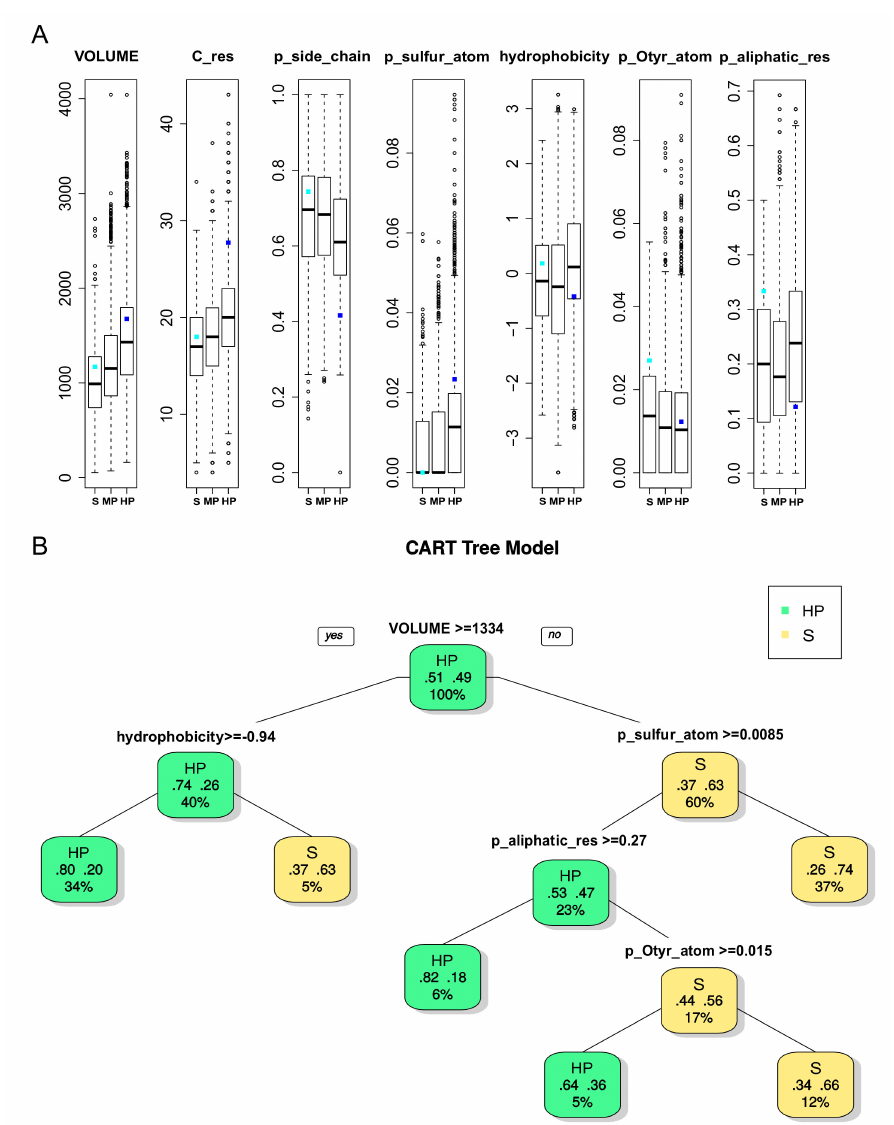
Figure 3. (A) Boxplot of seven pocket properties that di ff erentiated DBS with di ff erent levels of promiscuity (p value < 2 × 10–5). For each boxplot, the black bar in the rectangle represents the medium, the upper side is the third quartile, and the lower side is the first quartile of data. The dashed lines represent values below the first quartile limit and values above the third quartile limit. Circles represent atypical values (determined by the boxplot function). The cyan dot and the blue dot represent the values of the ligand in interaction with a lyase selective DBS (PDB 4KVI) and an urokinase HP DBS (PDB 1F5K), respectively, as illustrated in Figure 5. (B) Representation of the Classification And Regression Tree (CART) for pockets based on the pocket descriptors between the S (yellow) and HP (green) pockets. Each node is described by the class (promiscuity), the probability per class (right = HP and left = S), and the percentage of observations in the node. The CART model performances obtained for distinguishing pockets associated with the selective DBS from the HP DBS resulted in an average accuracy, sensitivity, and selectivity of 68%, 75%, and 67% for the test set (1,252 pockets), respectively, and 64% ± 2%, 60% ± 5%, and 64% ± 3% while using a five-fold cross validation on the training set (500 runs),